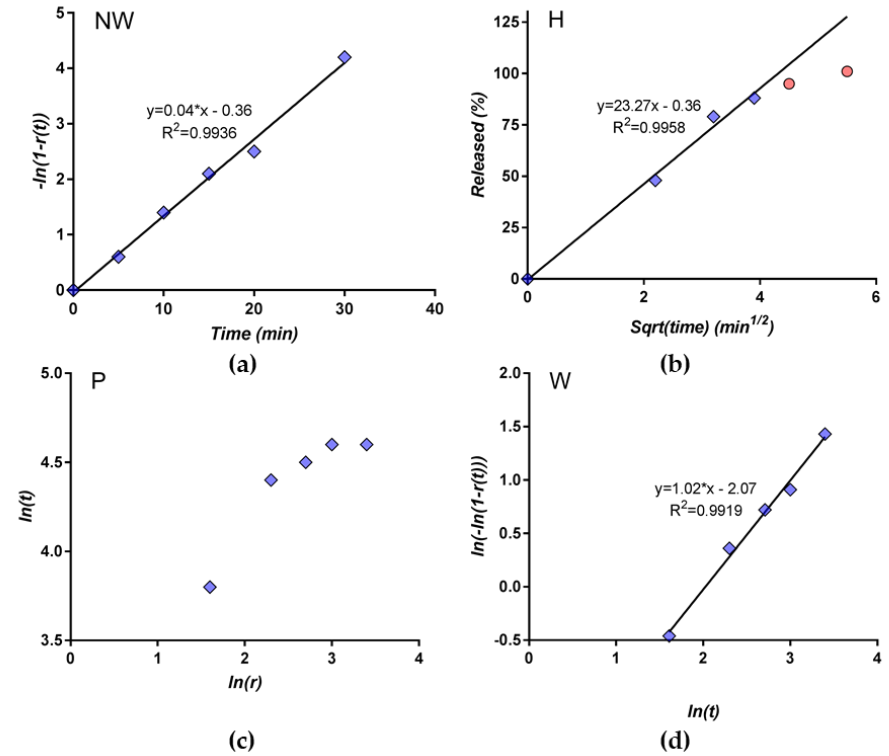
Figure 14. The linear regression of the transformed data: ( a ) the Noyes-Whitney model, ( b ) Higuchi model, ( c ) Peppas model and ( d ) Weibull model.